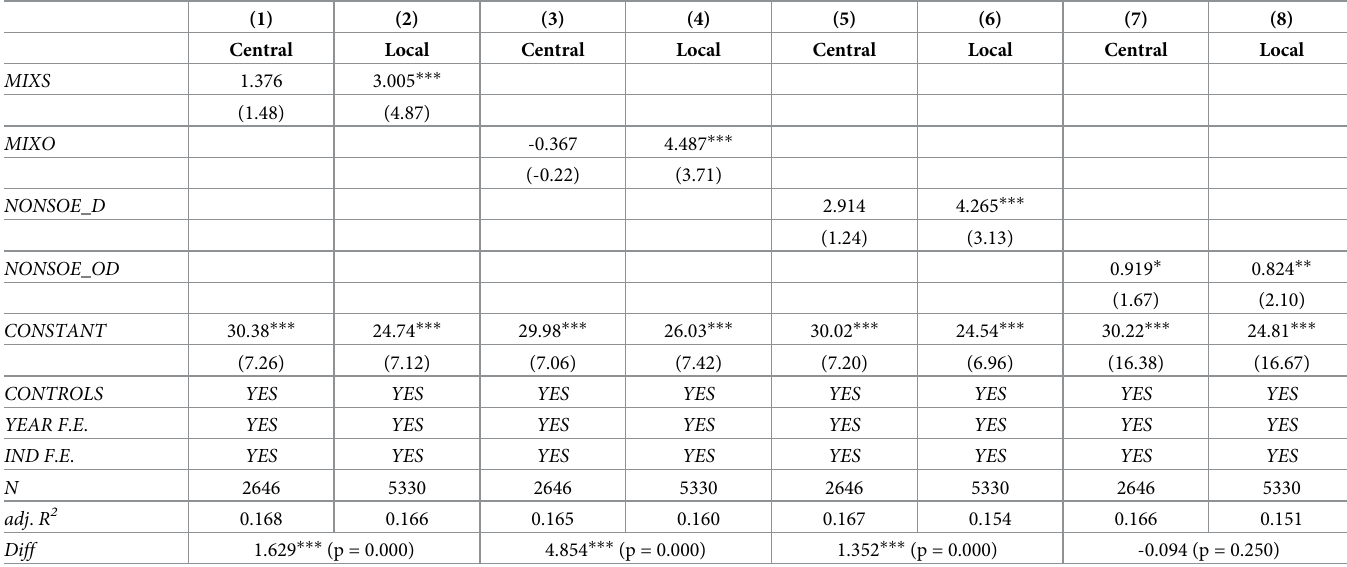
Table 14. The group inspection results of administrative